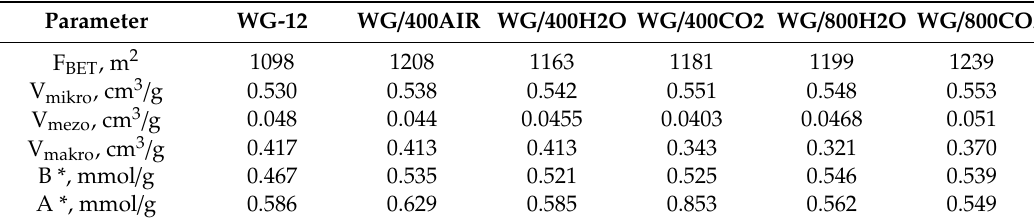
Table 8. Characteristic of modified activated